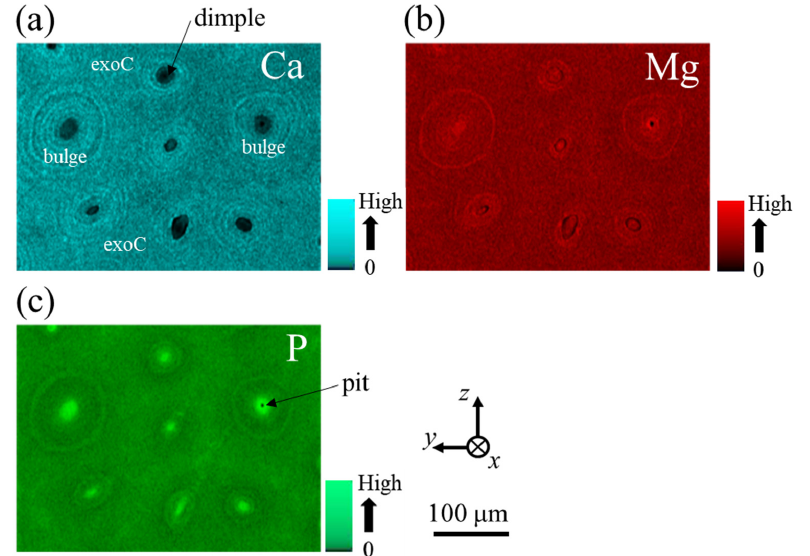
Figure 7. EDS maps showing the distribution of ( a ) calcium (Ca), ( b ) magnesium (Mg), and ( c ) phos- phorus (P) in a transverse section of the mottled, deep-blue exoskeleton. The SEM image for this area is shown in Figure 6b.